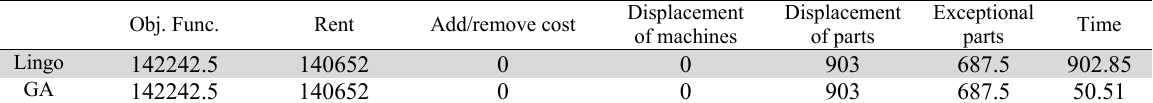
The results of comparison of GA versus optimal solution using Lingo software